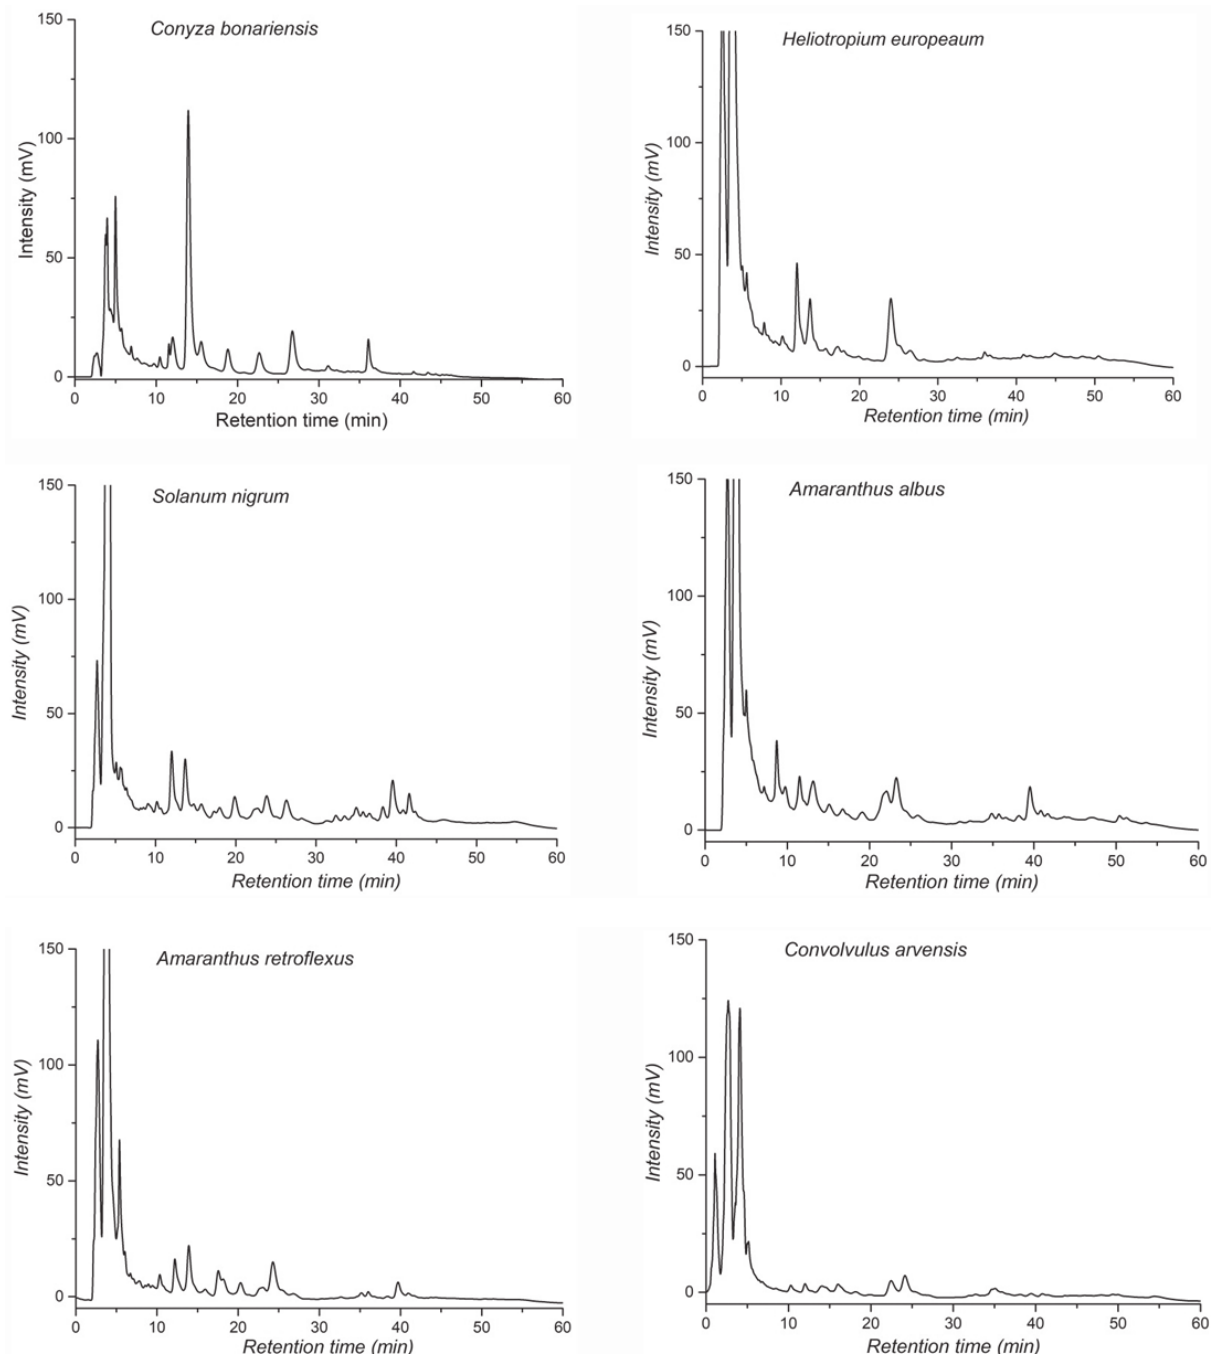
Figure 5. Optimized HPLC analysis of the extracts of the active plants: Conyza bonariensis L. , Heliotropium europaeum L., Solanum nigrum L. , Amaranthus albus L. , Amaranthus retroflexus L. and Convolvulus arvensis L.. The HPLCs were obtained using a 0.5 mL min -1 flow rate and the gradient: commencing from 60% MeCN – 40% 0.1% HCOOH for 30 min, and then linearly increasing from 60% to 90% MeCN in 20 min, and remaining at these conditions for 10 min. The phase was then followed by a re-equilibrium to the initial gradient composition for 10